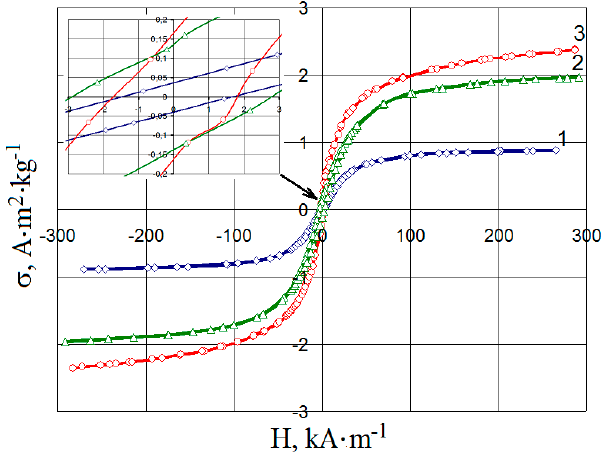
Figure 10. Magnetic hysteresis loops of Ni/ р HEMA-gr-PVP composites with different concentrations of NiSO 4 in the oxidation-reducing system (ORS) (H ЕМА :PVP:S ORS = 80:20:25 mass parts): 1 – [NiSO 4 ] = 0.55 mol/L; 2 – [NiSO 4 ] = 1.1 mol/L; 3 – [NiSO 4 ] = 2.32 mol/L.